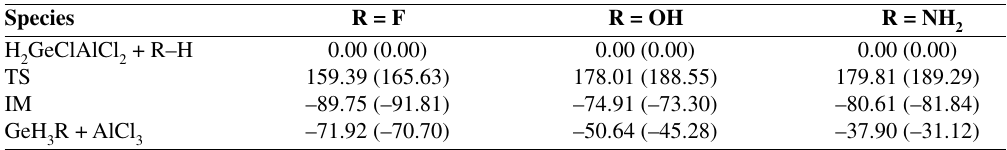
Table 1. Relative energies (in kJ/mol) of transition states (TSs), intermediates (IMs), and products of the substitution reactions of H